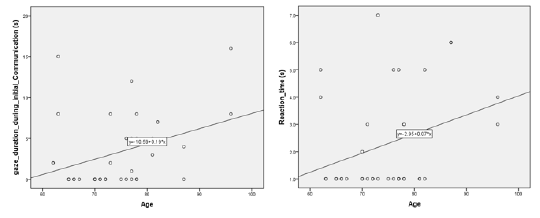
Figure 7: left) Correlation between age and gaze duration; right) Correlation between age and reaction time.